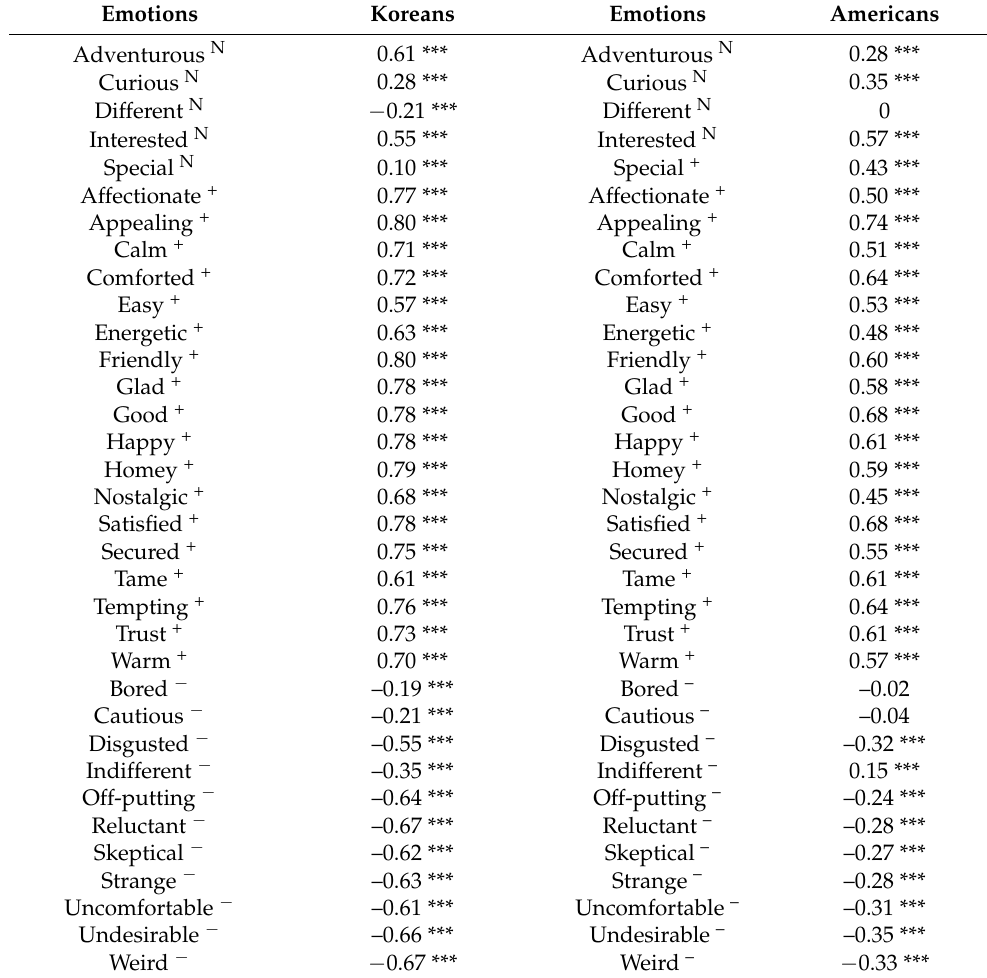
Table 8. Correlations between overall liking and the emotion terms elicited by the stimuli in the Koreans and the